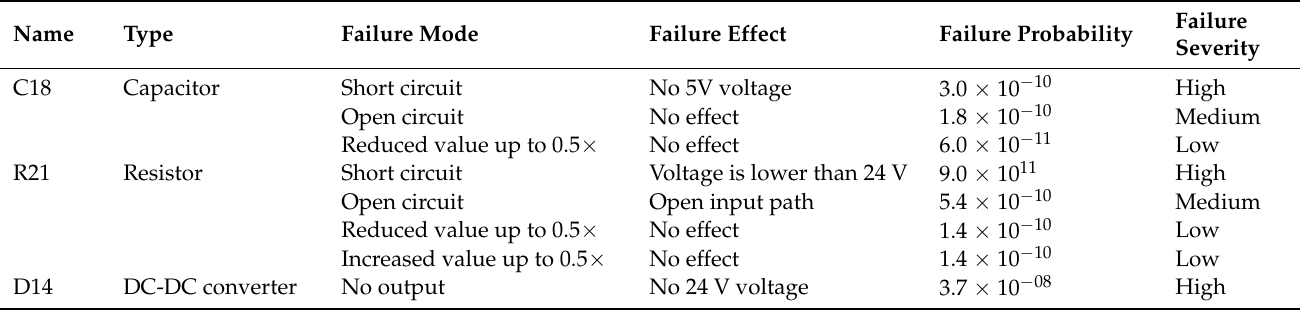
Table 7. FMECA example prepared by expert 2.